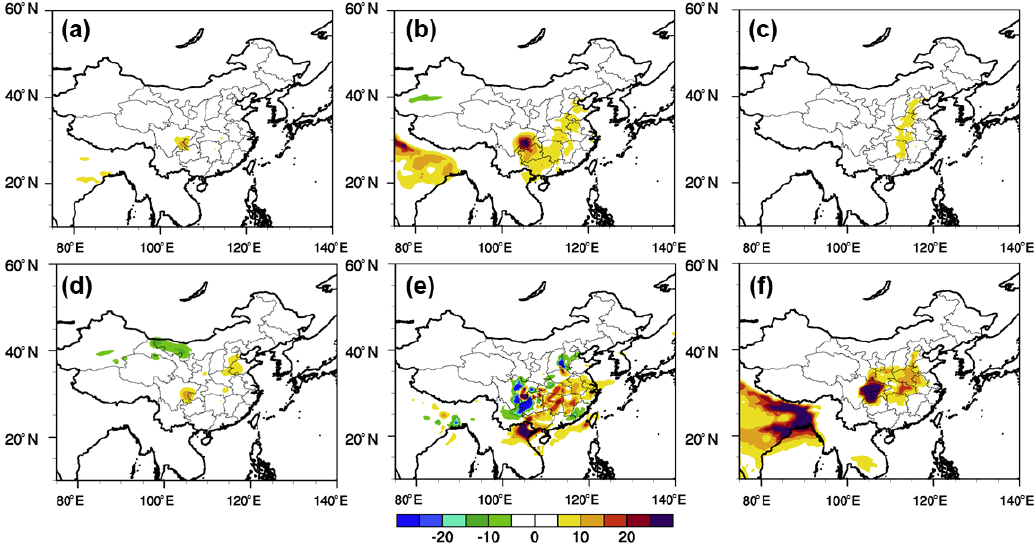
Figure 6. Monthly (January 2010) mean changes in surface PM 2 . 5 (µgm − 3 ) due to aerosol radiative effects from M1 (a) , M2 (b) , M4 (c) , M5 (d) , M6 (e) , and M7 (f) (M1: Pusan National University; M2: University of Iowa; M4: NASA; M5: Institute of Atmospheric Physics; M6: Nanjing University; M7: University of Tennessee; Gao et al., 2018a).